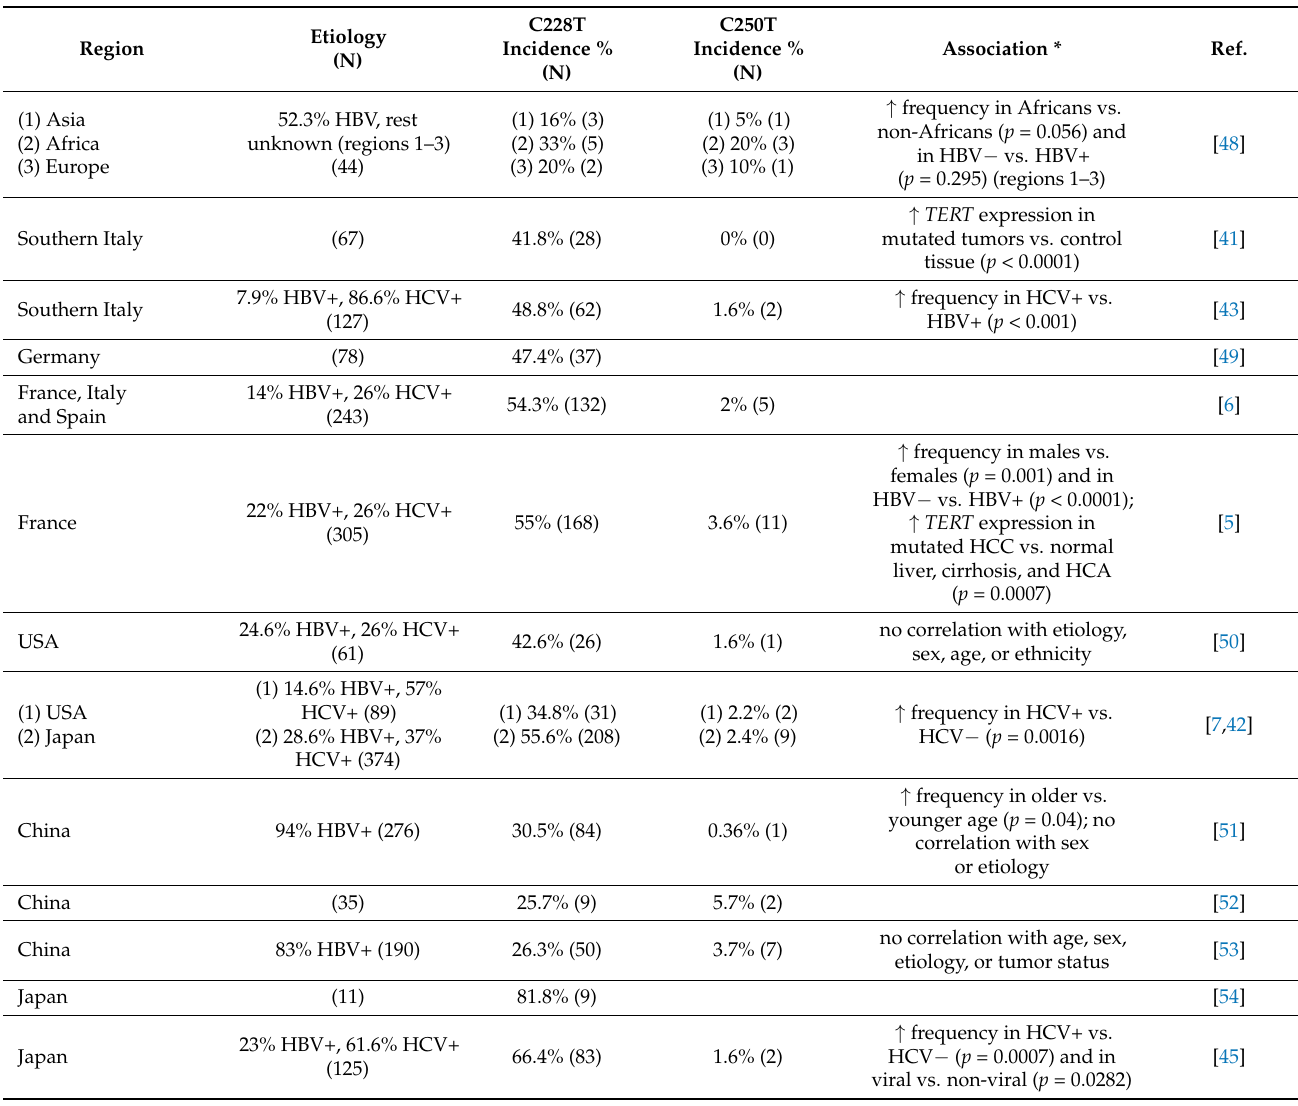
Table 2. Landscape of TERTp mutations in